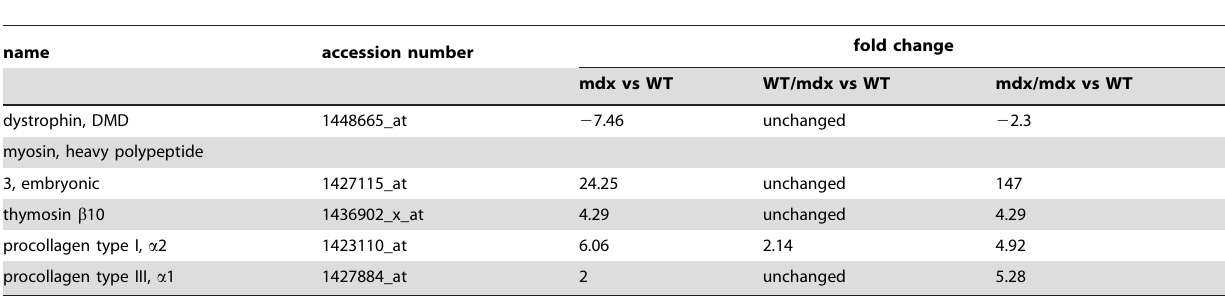
Table 2. Markers of muscular dystrophy are reversed in WT/mdx but not in mdx/mdx muscle.